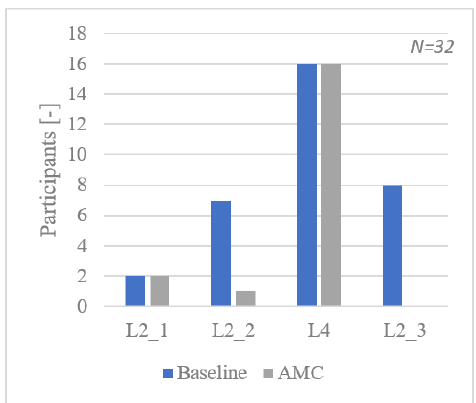
Figure 6. Boxplots for the road ahead attention ratio for different segments and divided by HMI condition. The L4 phase is displayed but not included in the statistical evaluation. The x represents the mean value.